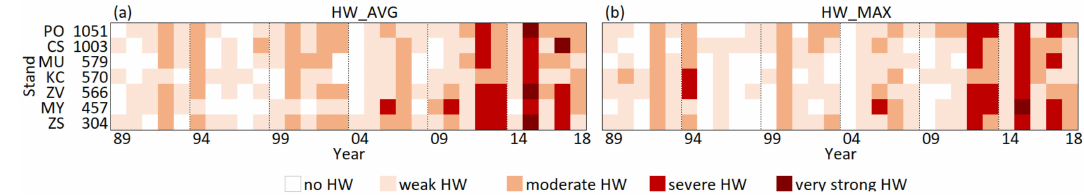
Figure 5. Heatwaves (HW) from June to August over the studied period 1989–2018. On the figure ( a ) are shown temporal changes of HW AVG when HW was calculated from the average daily temperatures and on the figure ( b ) are shown temporal changes of HW MAX when HW was calculated from the maximum daily